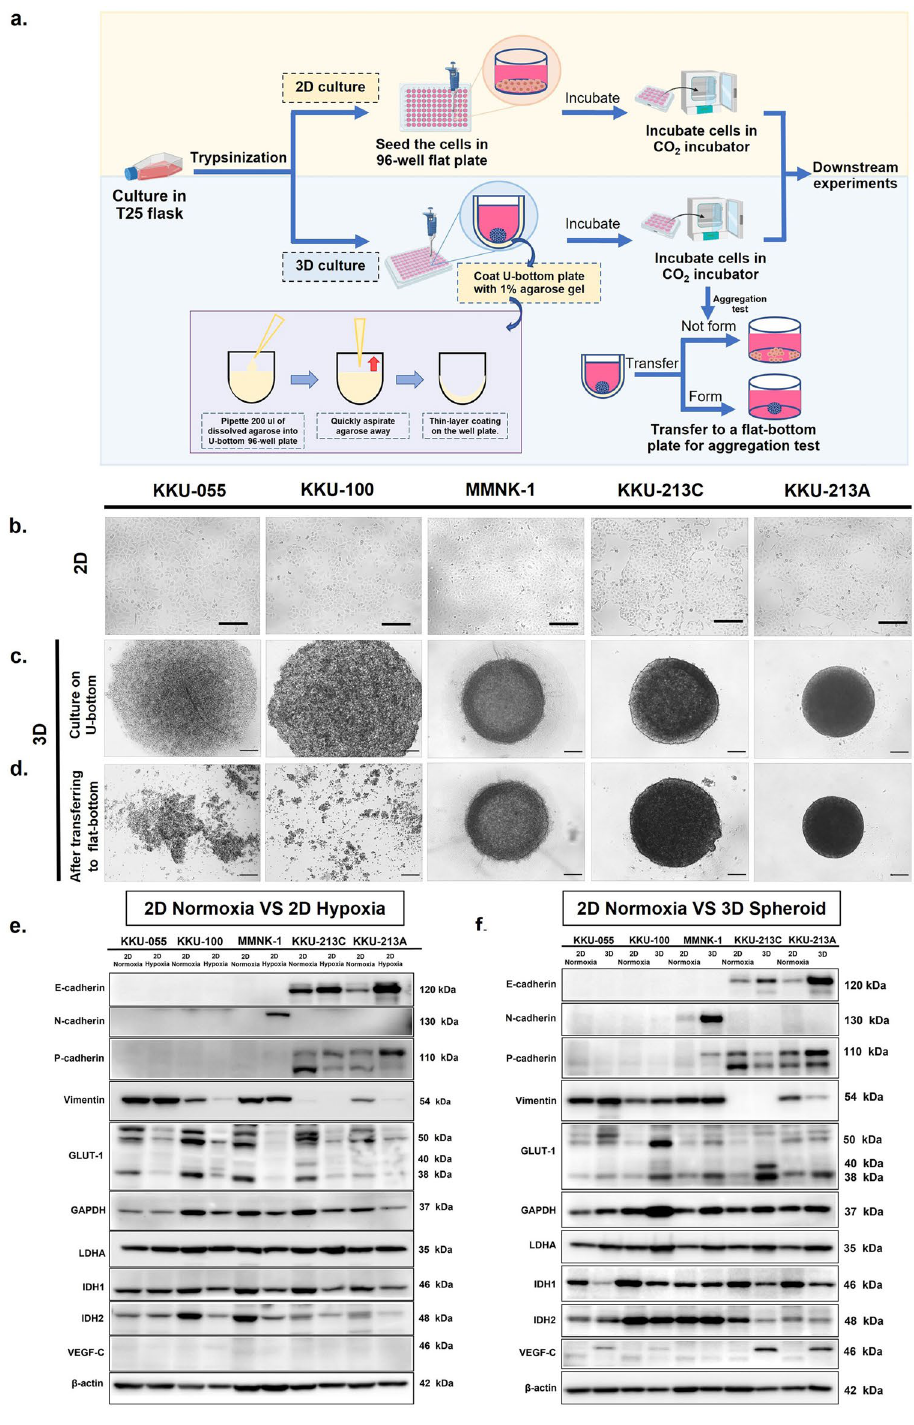
Figure 1. Formation of 3D MCSs using five CCA and cholangiocyte cell lines. ( a ) The process of agarose-coating (U-surface), showing the coating procedures. The illustration was created with BioRender.com. ( b ) Four CCA cell lines (KKU-055, KKU- 100, KKU-213C, KKU-213A) and one cholangiocyte cell line (MMNK-1) are shown. Each cell line is in a 2D monolayer culture system. ( c ) 3D cultures of 5 cell lines in the coated U-bottom plate, incubated for 48 h. ( d ) Cells transferred back to the flat-bottom plate, showing only KKU-055 and KKU-100 scattered to single cells, while the rest maintain intact spherical shape as 3D MCS, scale bar represents 200 µm. ( e and f ) Western blot analysis of cell-cell adhesion molecules (E-cadherin, N-cadherin, and P-cadherin), mesenchymal marker (vimentin), enzymes involved in the glycolytic pathway (GLUT-1, GAPDH, and LDHA), enzymes related to TCA cycle (IDH1 and IDH2), and angiogenic factor (VEGF-C) express on 2D normoxia vs. 2D hypoxia ( e ) and 2D normoxia vs. 3D spheroid ( f ) of CCA and cholangiocyte cell lines. Quantitative analysis of protein (normalized to β-actin) is shown in supplement S1. Data are means ± S.D. of at least three independent experiments. * P < 0.05, ** P < 0.01 and **** P <